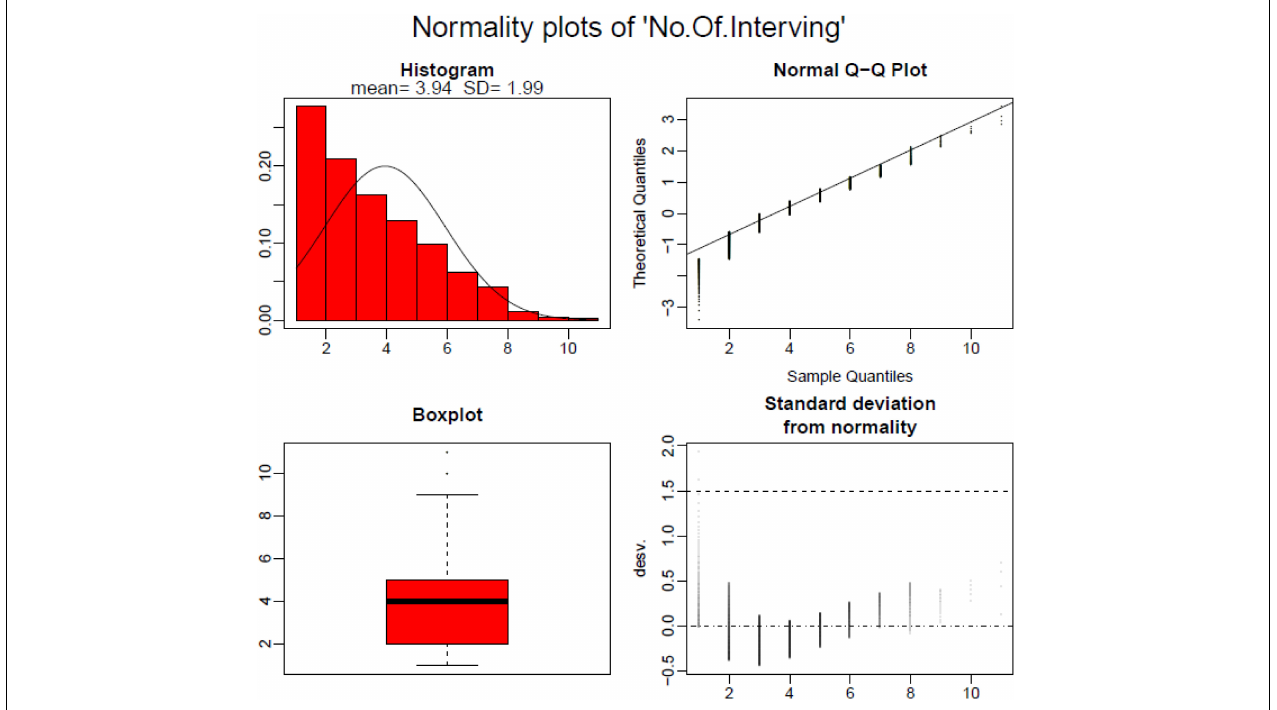
FIGURE 2 | Distribution for the quantitative variable Number of Intervening. Shapiro–Wilks p -value: < 001.